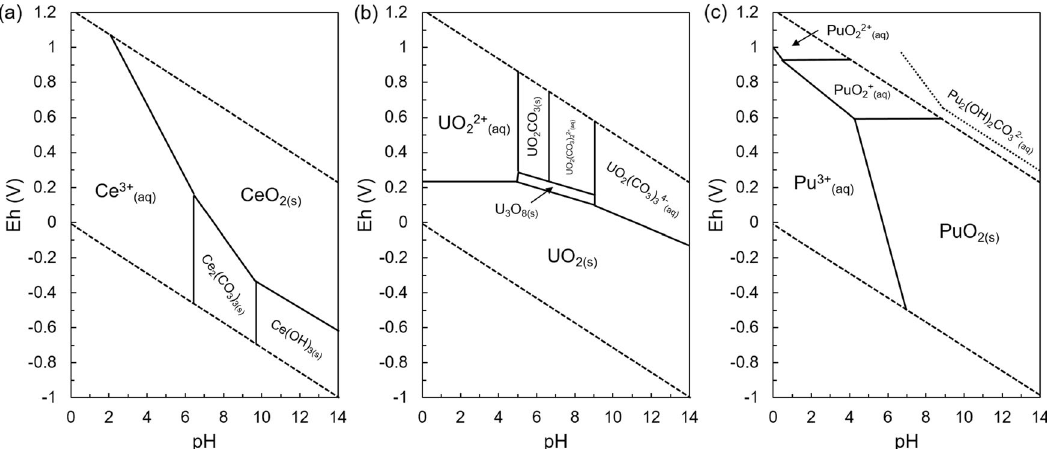
Fig. 8 Pourbaix diagrams for Ce, U and Pu. Showing a the Ce – C – O – H system; b the U – C – O – H system; and c the Pu – (C) – O – H system all at 25 °C and 1 bar, with 10 − 6 M Ce, U and Pu, and 10 − 3 M C. C is included since the experiments were performed in equilibrium with atmosphere CO 2 . Adapted from Brookins 33